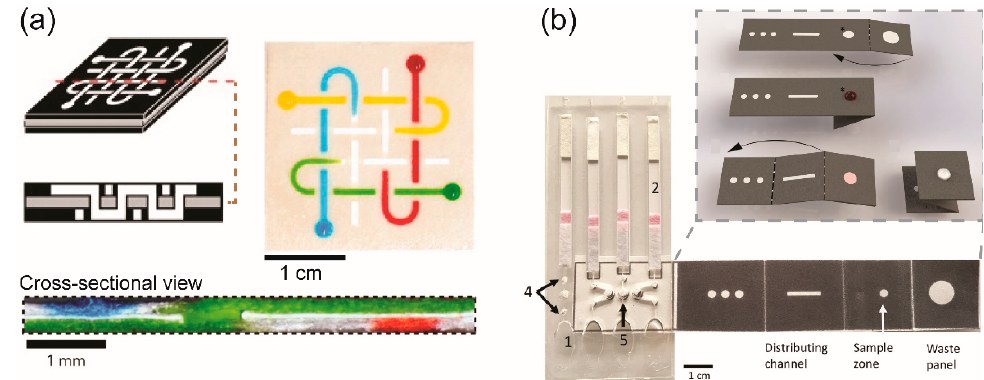
Figure 2. Representative methods for the fabrication of 3D- µ PADs. ( a ) 3D- µ PAD was fabricated by stacking layers of paper channels and adhesive tapes to form 3D channels. Reproduced with permission from the authors of [58]. Copyright 2008, The National Academy of Sciences of the USA. ( b ) 3D- µ PAD was fabricated by using an origami method to form a 3D channel. The channels were folded that allowed fluid samples to flow in a vertical direction. Reproduced with permission from the authors of [86]. Copyright 2019 under the terms and conditions of the Creative Commons Attribution.